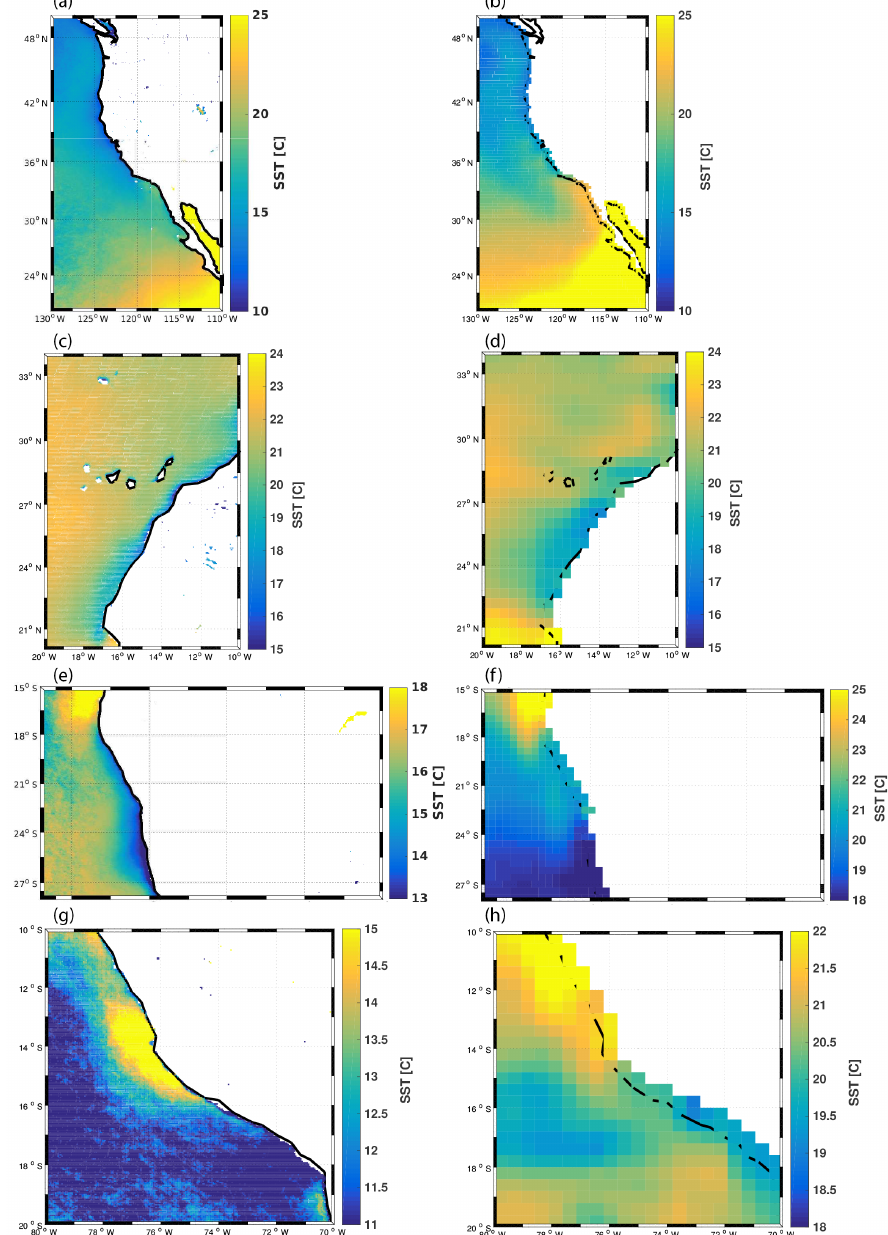
Figure 1. Mean sea surface temperature in the four upwelling regions in the corresponding main upwelling season for 1985–2005 simulated by the Earth system model MPI-ESM compared to satellite data from AVHRR. California (June–August) AVHRR (a) and MPI-ESM histori- cal r 1 (b) ; Canary (June–August) AVHRR (c) and MPI-ESM historical r 1 (d) ; Benguela (September–November) AVHRR (e) and MPI-ESM historical r 1 (f) ; and Peru (June–August) AVHRR (g) and MPI-ESM historical r 1 (h) . Not the different temperature scale for Benguela and